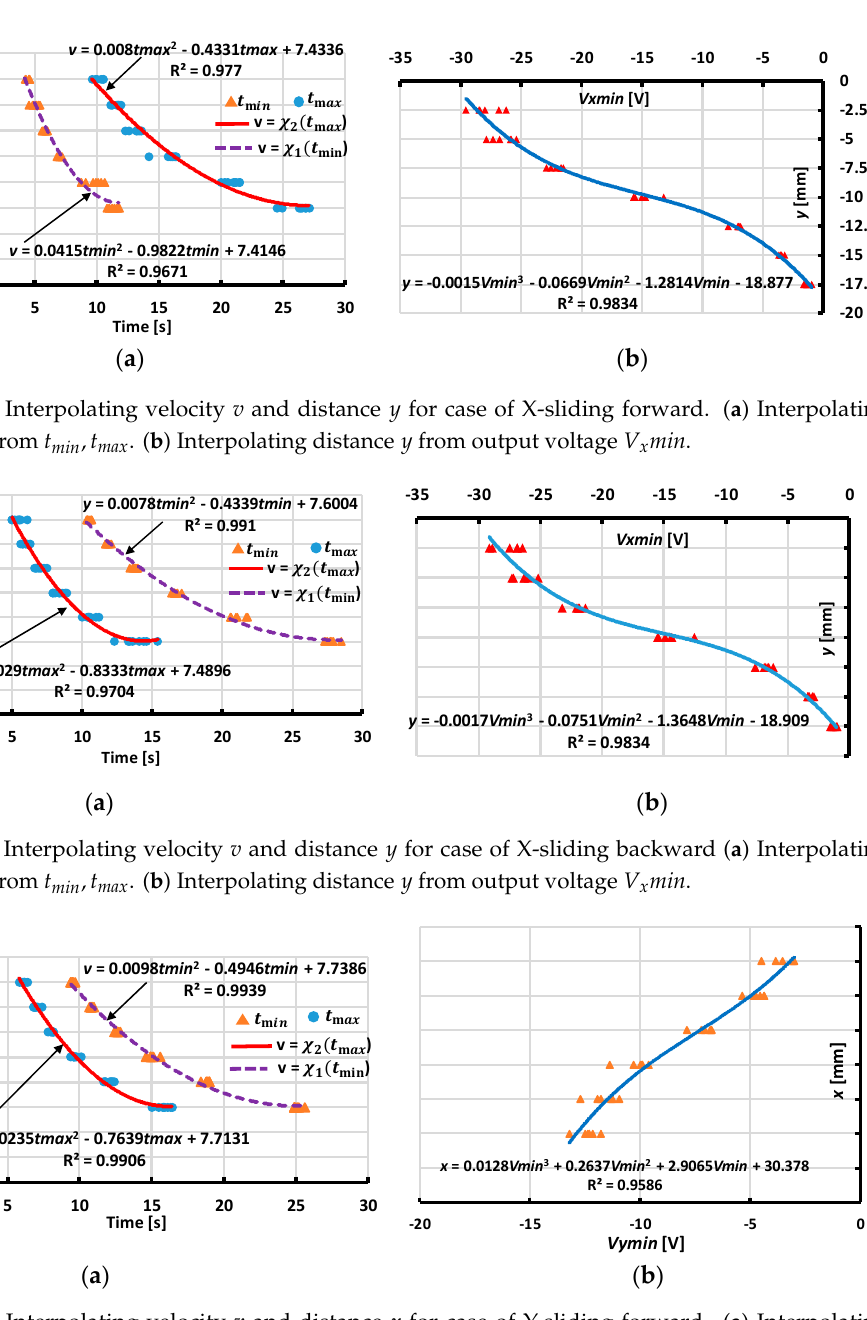
Figure 19. Interpolating velocity v and distance x for case of Y-sliding forward. ( a ) Interpolating Figure 19. Interpolating velocity 𝑣 and distance 𝑥 for case of Y-sliding forward. ( a ) Interpolating Figure 19. Interpolating velocity 𝑣 and distance 𝑥 for case of Y-sliding forward. ( a ) Interpolating velocity v from t min , t max . ( b ) Interpolating distance x from output voltage V y min velocity 𝑣 from 𝑡 (cid:3040)(cid:3036)(cid:3041) ,𝑡 (cid:3040)(cid:3028)(cid:3051) . ( b ) Interpolating distance 𝑥 from output voltage 𝑉 (cid:3052) 𝑚𝑖𝑛 . Figure 19. Interpolating velocity 𝑣 and distance 𝑥 for case of Y-sliding forward. ( a ) Interpolating velocity 𝑣 from 𝑡 (cid:3040)(cid:3036)(cid:3041) ,𝑡 (cid:3040)(cid:3028)(cid:3051) . ( b ) Interpolating distance 𝑥 from output voltage 𝑉 (cid:3052) 𝑚𝑖𝑛 . velocity 𝑣 from 𝑡 (cid:3040)(cid:3036)(cid:3041) ,𝑡 (cid:3040)(cid:3028)(cid:3051) . ( b ) Interpolating distance 𝑥 from output voltage 𝑉 (cid:3052) 𝑚𝑖𝑛 .